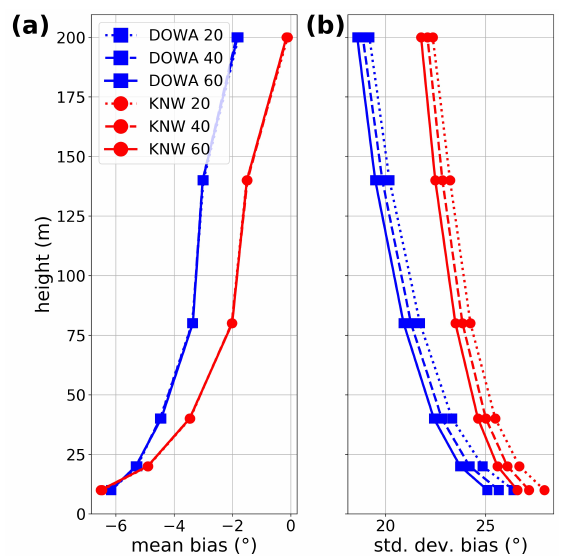
Figure A3. Height profile of ( a ) the mean bias and ( b ) standard deviation of the bias of the wind direction data, comparing the DOWA (blue) and KNW atlas (red), for different averaging times (20, 40, and 60 min) of the mast